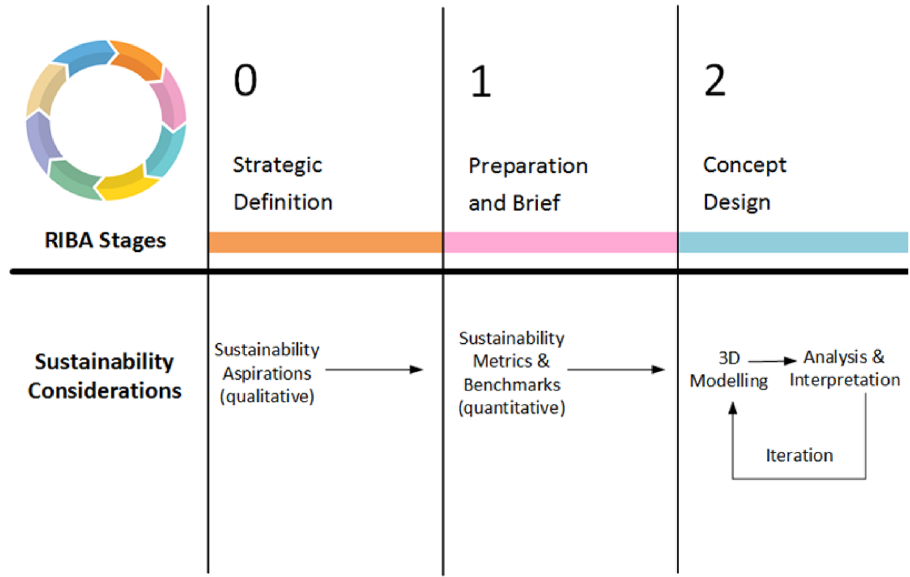
Fig. 1 Sustainability definition aligned with the RIBA plan